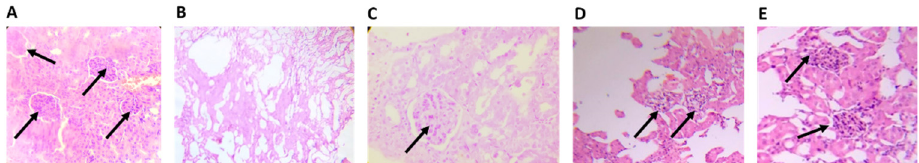
Figure 8. Effect of the butanol fraction from calyces of P. peruviana on kidney tissue at 50 mg/kg and 100 mg/kg. ( A ) Untreated diabetic group (vehicle); ( B ) normal control group; ( C ) diabetic group treated with metformin 250 mg/kg; ( D ) diabetic group treated with BFPP 50 mg/kg; ( E ) diabetic group treated with BFPP 100 mg/kg. Micrographs were stained with H&E, with a magnification of 40× and 100×. Arrows show the presence of renal glomeruli.